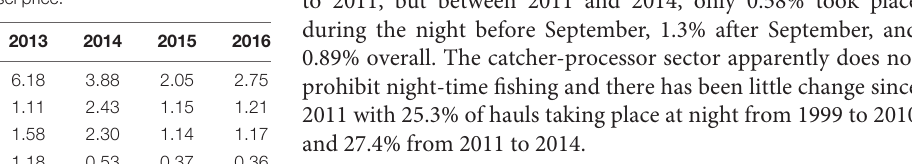
TABLE 2 | Ratio of quota pound price/ex-vessel